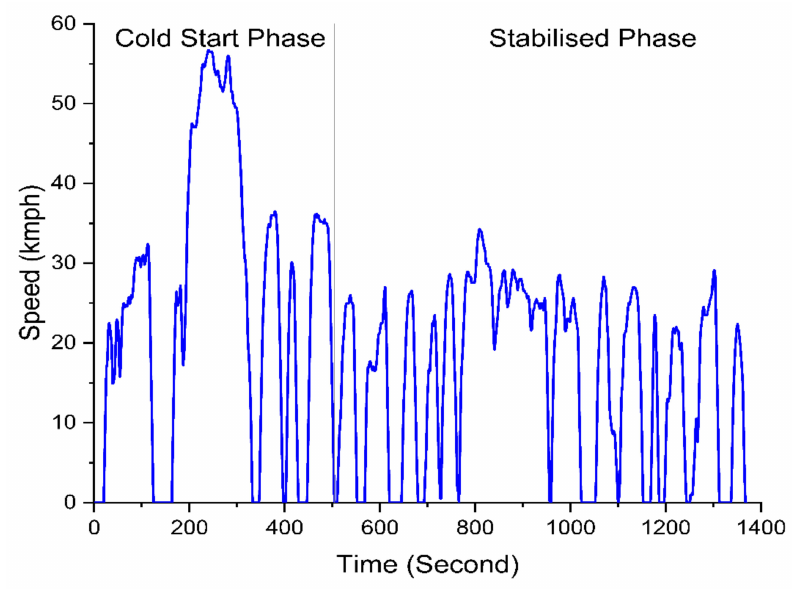
Figure 7. Speed-time cycle of EPA UDDS/FTP-72 (40 CFR 86, App. I). Another cycle used for LDV certification is the FTP-75 cycle (also known as EPA75) which is derived from the FTP-72 and was introduced in 1975. Since then, it has been the ‘primary’ cycle used in the US for TA of LDVs. FTP75 was created by using the third phase of 505 s, similar to the first phase of FTP-72 but with a hot start. The third phase begins after the engine has been stopped for 10 min. Figure 8 illustrates the driving time speed profile of the FTP-75. Diesel engine cars were included as passenger vehicles starting with the 1975 model year. As opposed to running only one 12 km cycle from a cold start, this test provides a more realistic real-world driving experience.